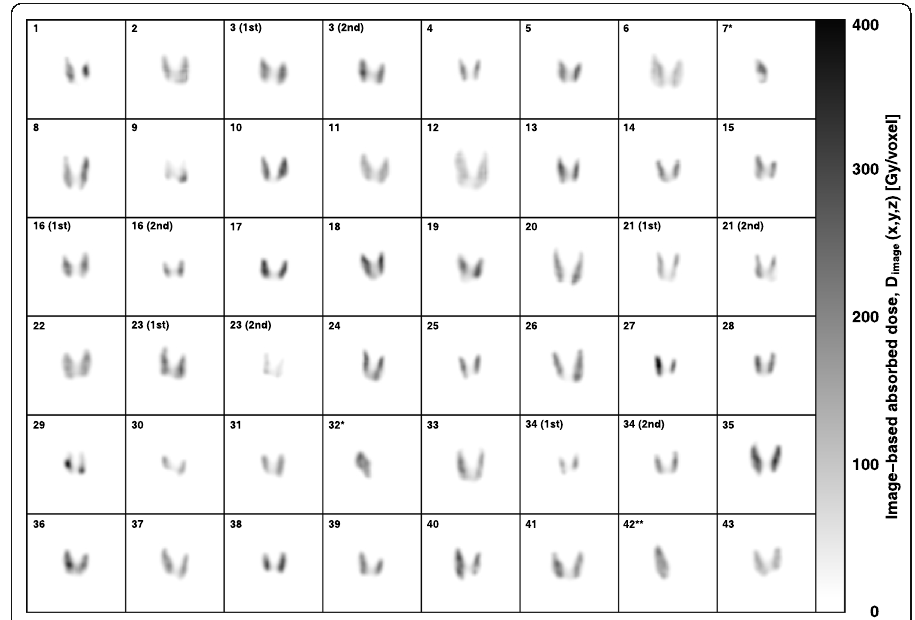
Fig. 1 Absorbed dose image of thyroid obtained from each patient (coronal image). The accumulation of iodine in the thyroid was not completely homogeneous even for patients with Graves ’ disease. Patient nos. 7 and 32 were imaged after undergoing subtotal thyroidectomy. Patient no. 42 had thyroid hemiagenesis